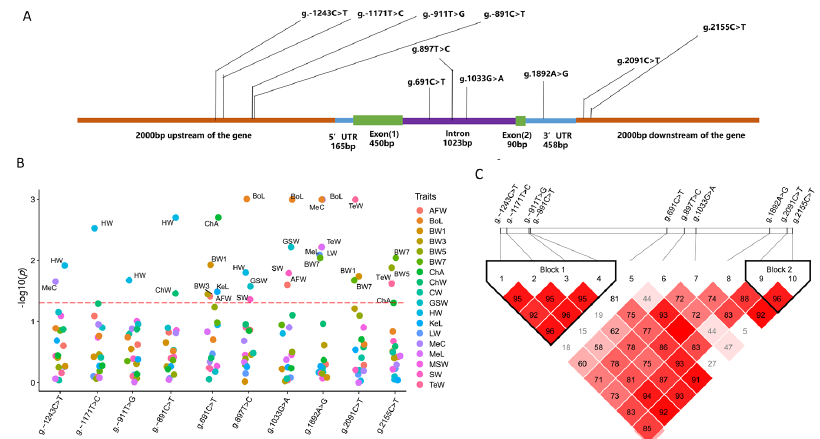
Figure 3. Identification of functional SNPs in the TCF21 gene. ( A ) The distribution of SNPs in the TCF21 gene. ( B ) Associations of TCF21 gene polymorphisms with the growth and body composition traits in G21 populations. The red line indicates the significant threshold p < 0.05. ( C ) Linkage disequilibrium (LD) analysis of these 10 SNPs.